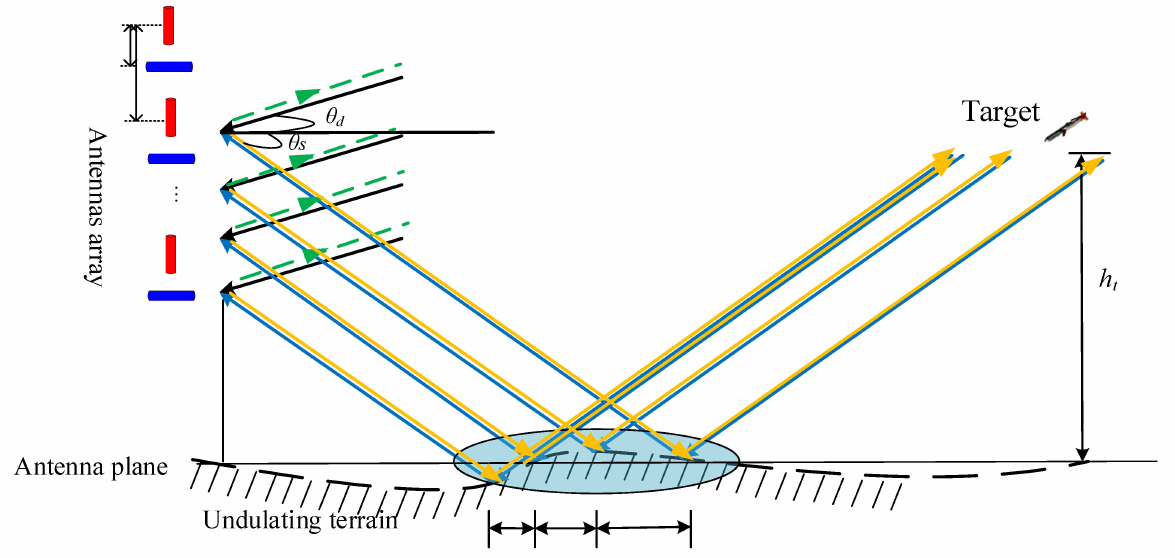
Figure 1. Height measurement signal model of separated electrically long dipole MWP‑MIMO